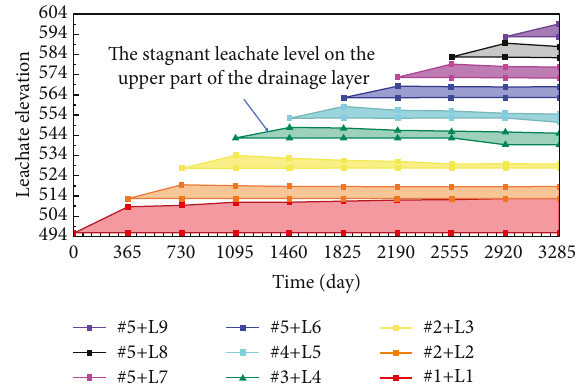
Figure 12: Leachate level distributions (Scheme